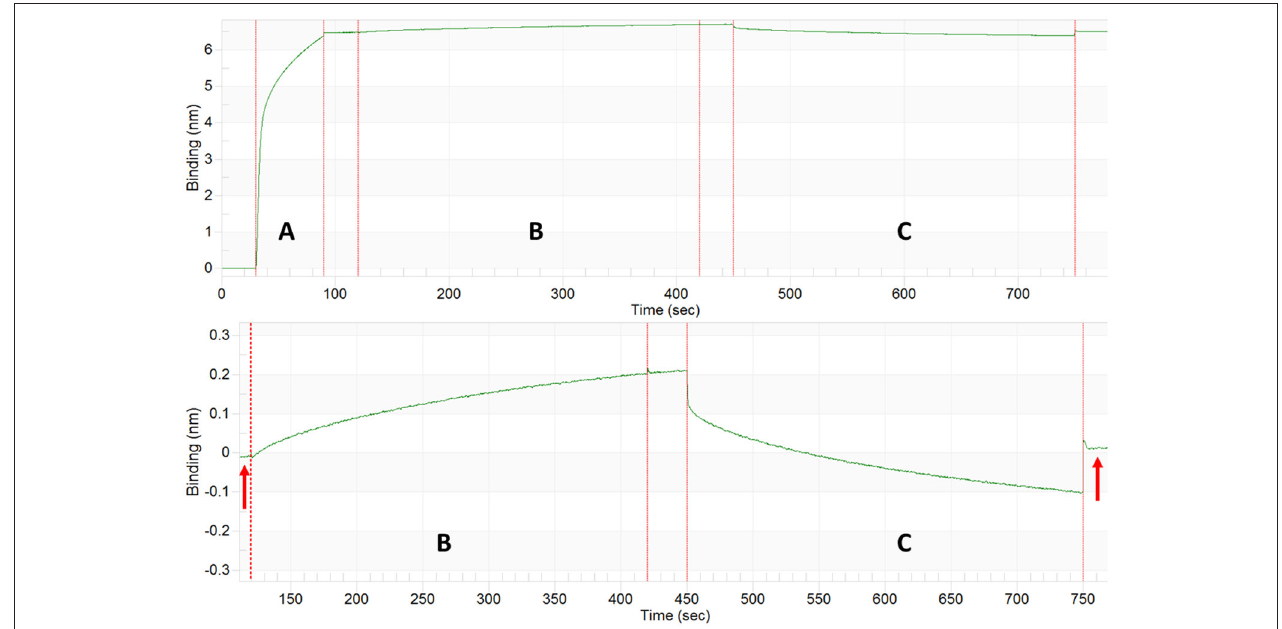
FIGURE 10 | Tetanus Neurotoxin Capture and ATP Release by GroEL Biosensor. Top: BLI sensogram indicating biotinylated GroEL association (A) , TeNT capture by the GroEL biosensor (B) , and ATP release of TeNT from GroEL biosensor (C) . Bottom: Enlargement of TeNT capture and release steps to highlight amplitude change for capture and release. The baselines before association and after ATP dissociation match indicating that the signal increase and decrease are solely from GroEL capturing and releasing TeNT (red arrows). The large initial shifts in the trace for the ATP phase (C) are due to a refractive index changes and not a change in protein